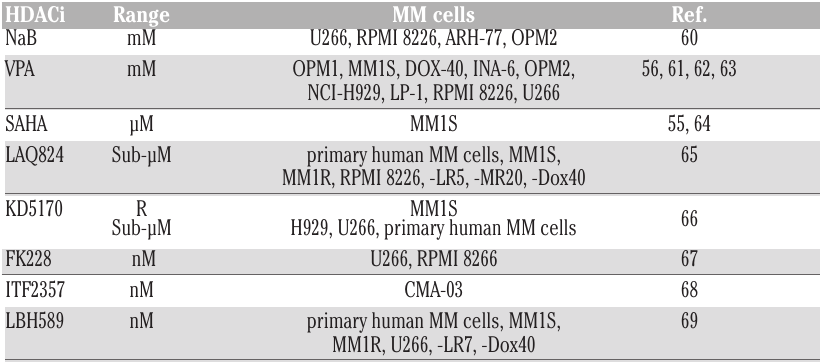
Table 2. Potency of HDACi used in different in vitro MM